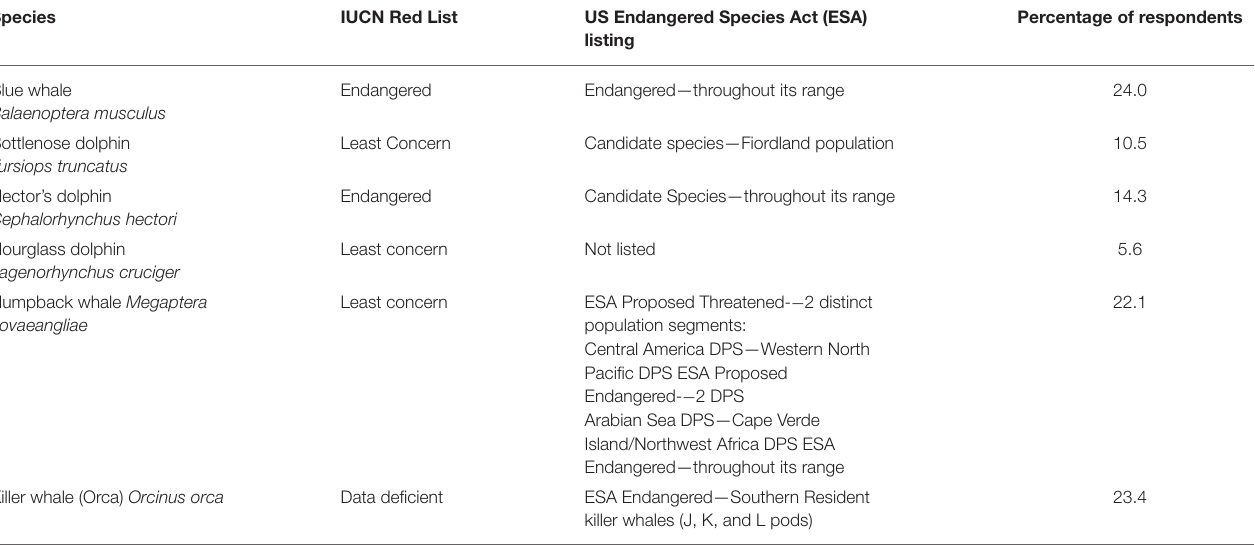
Percentage of respondents